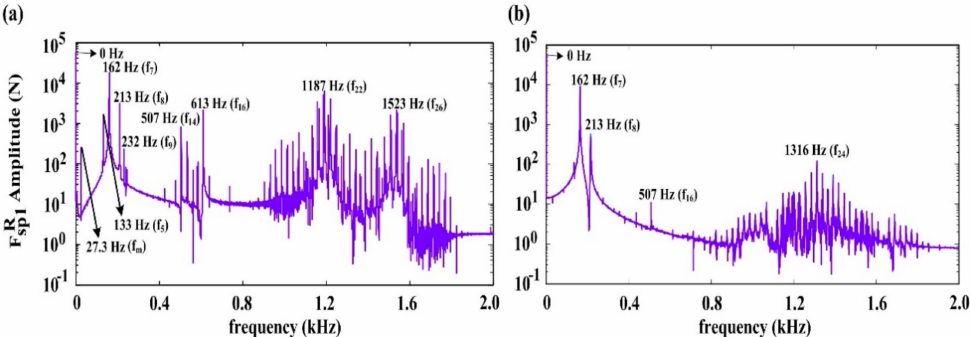
( t ) attheright-sidegearpair. ( a )themodel sp1